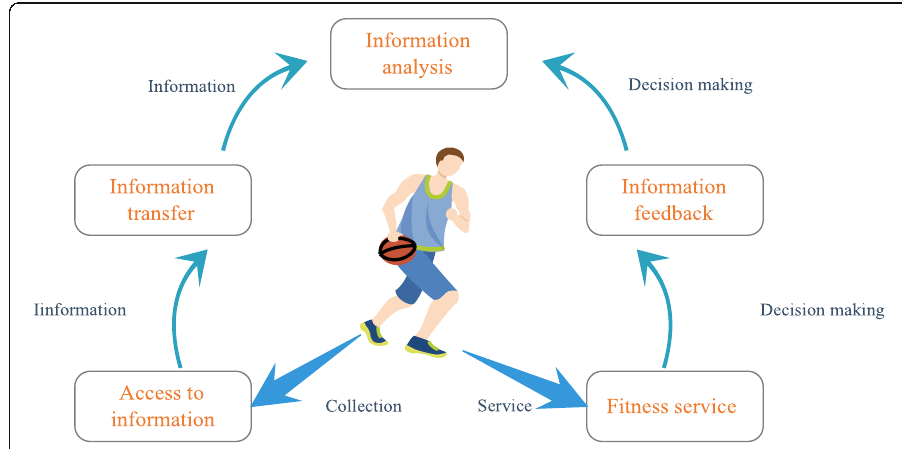
Fig. 1 Schematic diagram of the information function of the Internet of